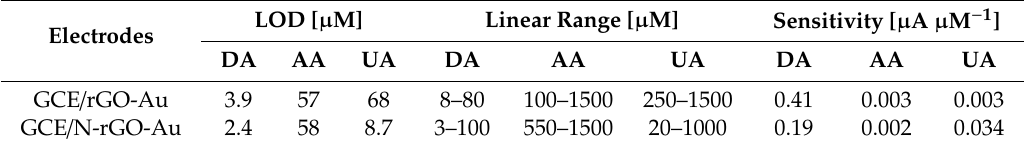
Figure 5. DPVs recorded on the GCE / rGO-Au ( a – c ) and GCE / N-rGO-Au ( d – f ) electrodes in the presence of DA, AA, and UA in 0.1 PBS (7.0). ( a , d ) 300 µ M UA, 300 µ M AA, and increasing concentrations of DA; ( b , e ) 100 µ M DA, 300 µ M UA, and increasing concentration of AA; ( c , f ) 100 µ M DA, 300 µ M AA, and increasing concentration of UA. Table 3. Electrochemical performance of GCE / rGO-Au and GCE / N-rGO-Au electrodes towards simultaneous detection of DA, AA, and UA.